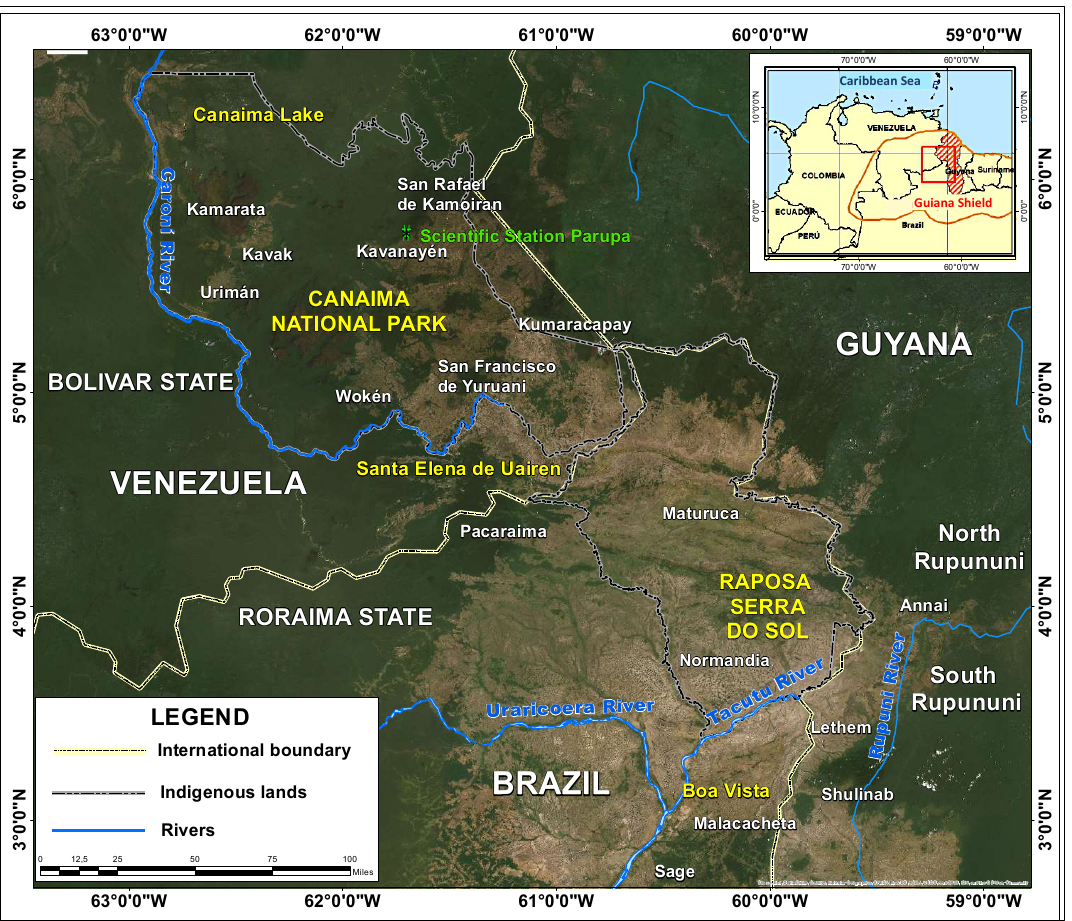
Figure 1. Map showing the locations inhabited by the different Indigenous communities from Venezuela, Brazil, and Guyana that attended the workshop. Green areas indicate woodland ecosystems and brown ones savannas. White circles indicate Indigenous communities, yellow circles indicate localities of reference (e.g. Boa Vista, capital of Roraima State of Brazil) and the bright green triangle indicates Scientific Station Parupa (the workshop place). Indigenous lands: Canaima National Park, Venezuela: Pemón Indigenous peoples (Arekuna, Kamarakoto, and Taurepang); Raposa Serra do Sol, Roraima, Brazil: Makushi and Wapishana Indigenous peoples; North and South Rupununi, Guyana: Makushi and Wapishana Indigenous peoples (map elaborated by Jonathan Rodríguez, Roberto Rivera and Bibiana Bilbao).